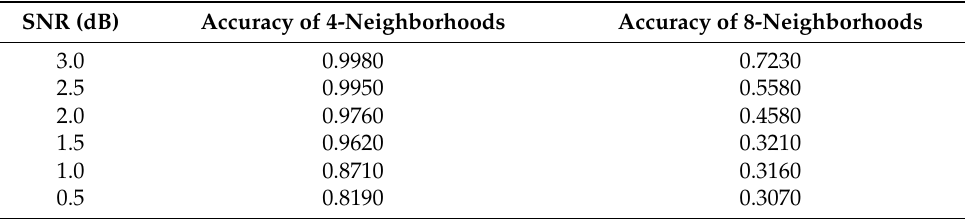
Figure 9. Experimental results from 2.0 to 3.0 dB: ( a – c ) are the original images. ( d – f ) are the results of 8-neighbour. ( g – i ) the results of 4-neighbour. Table 1. Comparative experimental results of 4-neighborhoods and 8-neighborhoods.